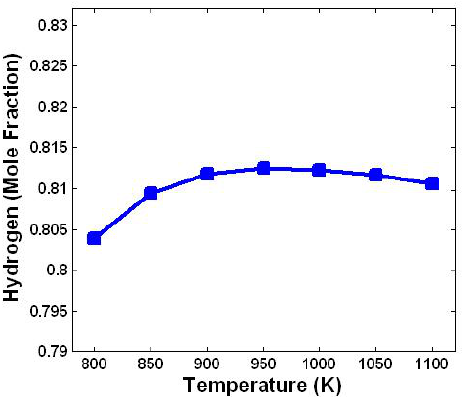
Figure 2. Effect of temperature on hydrogen production. Biomass feed rate: 0.072 kg/h; Steam/biomass ratio: 3.0; Sorbent/biomass ratio: